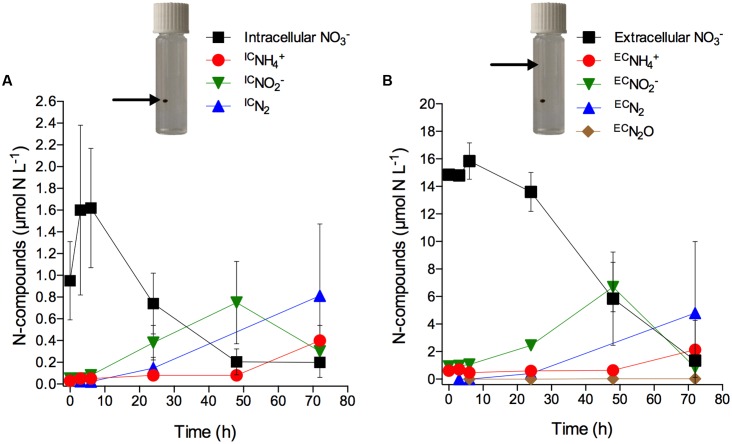
Anaerobic turnover of intracellular nitrate in diatom-bacteria aggregates. Concentration time series of (A) intracellular NO3− (expressed in μmol N L-1 of incubation water; initial NO3− concentration per cell was 18.0 ± 3.3 mmol L-1) and intracellular NO3−-derived ICNH4+, ICNO2−, and ICN2, and (B) extracellular NO3− and extracellular NO3−-derived ECNH4+, ECNO2−, ECN2, and ECN2O (see Materials and Methods for the calculation of ICN- and ECN-concentrations). Dark and anoxic conditions were initiated directly after t0. Values are means ± SD (n = 3). Note different scales. Pictures show incubation vials with diatom-bacteria aggregates; arrows indicate the respective source of NO3− that drives anaerobic nitrogen cycling (i.e., intracellular NO3− inside the aggregate vs. extracellular NO3− in the surrounding water).